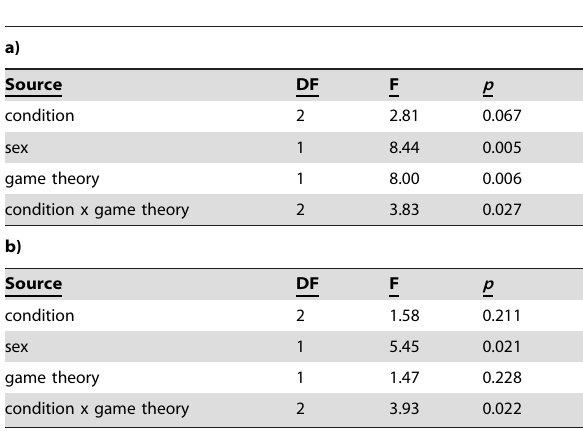
Table 1. Analysis of variance for individual investment in a) round 3 and b) rounds 4 and 5 of the public goods